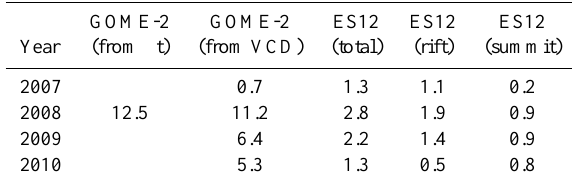
Table 4. Monthly mean emission rates (in ktday − 1 ) from GOME-2 compared to Elias and Sutton (2012) (ES12) for the Junes of 2007–